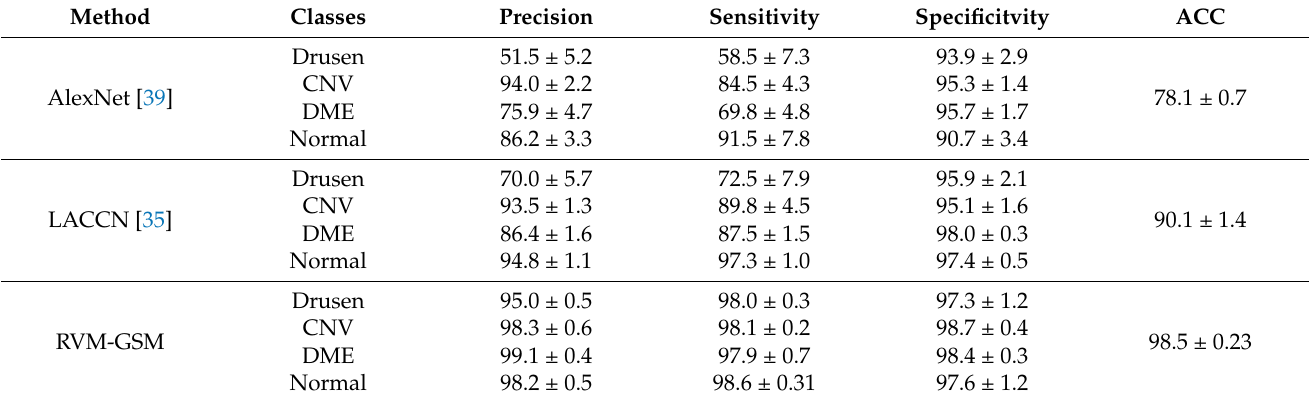
Figure 8. Sample category visualization for the UCSD dataset. ( a ) Normal: The normal retina presents regular depressions; ( b ) Choroidal Neovascularization (CNV): Due to thickening and enhanced reflection of the epithelial layer/choroidal capillaries in the retina, protrusions appear in the image in a fusiform or elliptical shape; ( c ) DME: Due to the accumulation of retinal fluid, retinal thickness increased and reflectivity decreased, resulting in an increase in central thickness and a decrease in intensity of the image; ( d ) Vitreous Warts (DRUSEN): In the corresponding area of the glass membrane wart, a low reflection area caused by shielding can be seen, presenting a special image of a hat-like high reflection boundary accompanied by a low reflection area of a lower void-like cavity. Table 5. Experimental comparison of the effects of models on the ucsd dataset